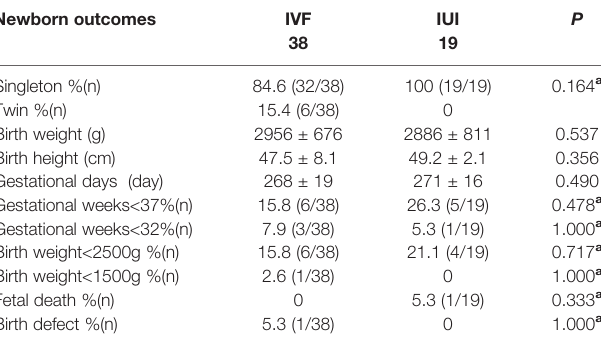
TABLE 8 | Neonatal outcomes after IVF and